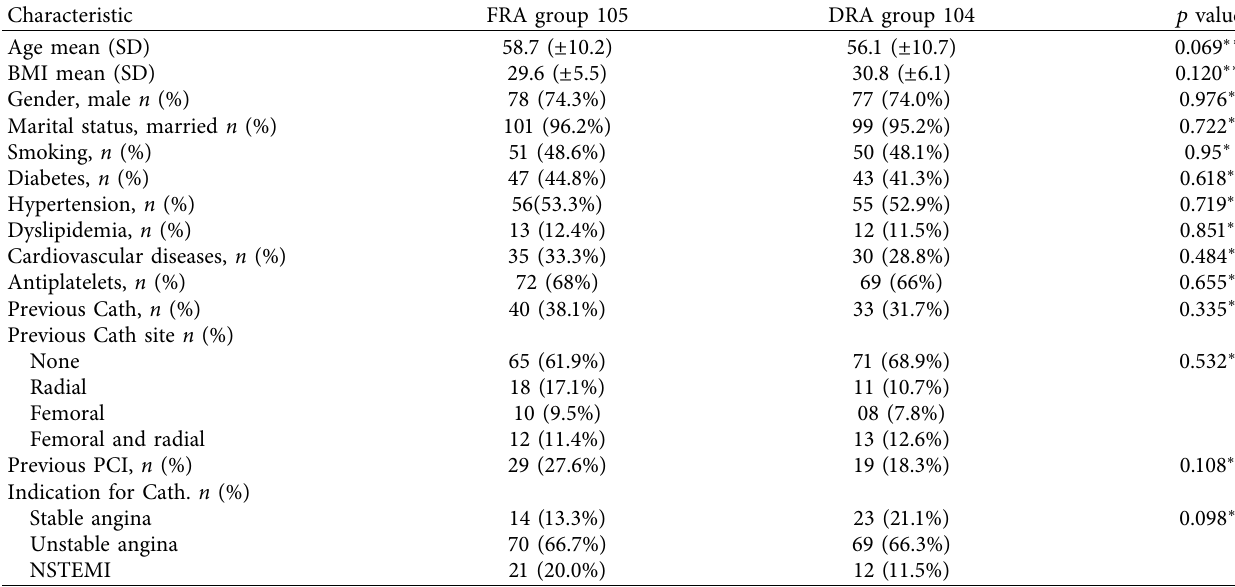
Table 1: Baseline demographics and clinical characteristics of the participants.